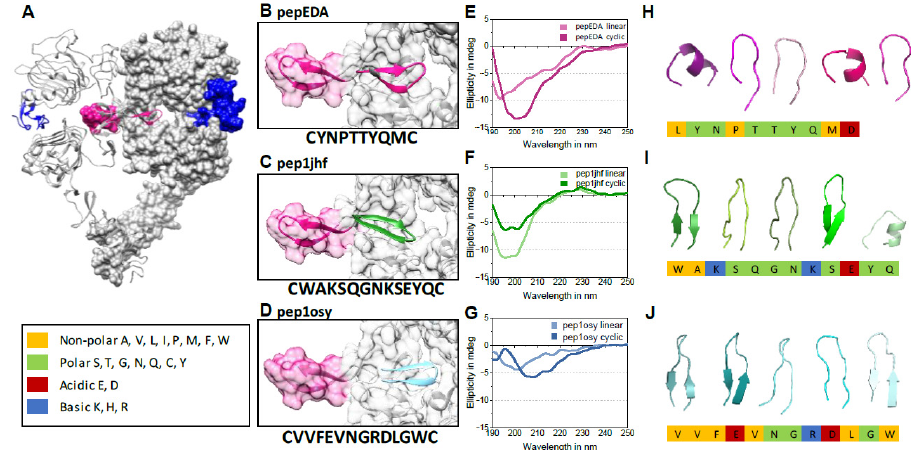
Figure 1. Epidermal growth factor receptor (EGFR) crystal structure, peptide binding models, and circular dichroism (CD) spectra. ( A ) Cocrystallization of the dimerized human EGFR extracellular domains and the natural ligand EGF (blue) (protein databank (PDB) 3NJP). The EGFR dimerization arm (EDA) is highlighted in magenta in both domains. ( B – D ) Model structures of designed peptides docked into the dimerization interface. Ribbon representations of peptides are highlighted in color, peptide names are inset, and peptide amino acid sequences are listed below the image. ( E – G ) Circular dichroism (CD) spectra of linear and cyclic peptides (100 μ M, 10% TFE/water ( v / v ), 190 to 250 nm, 25 °C) (for absorption spectra see Figure S1). ( H – J ) 3D structure models of disulfide ‐ bridged peptides as calculated by the online tool PEP ‐ FOLD 2.0 and the top 5 clusters are shown in ribbon structure as created using the program PyMOL. The chemistry of the individual amino acid residues is color ‐ coded according to the legend on the left.